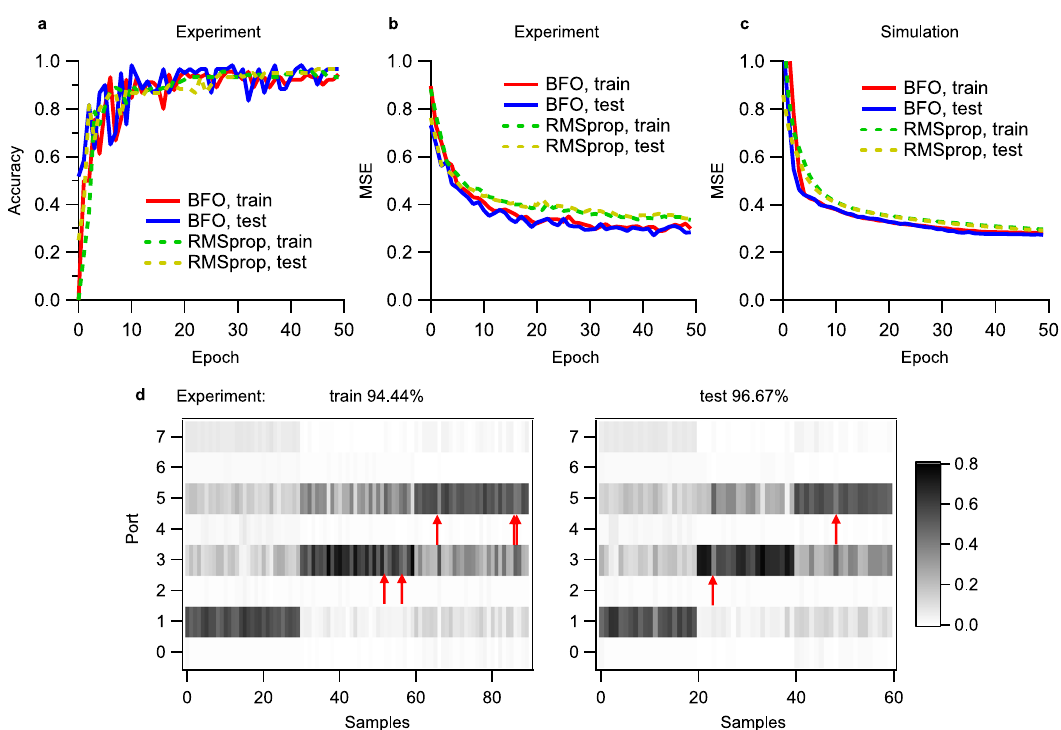
Fig. 5 Iris classi fi cation experiment. Comparisons between BFO and RMSprop training: a Experimental accuracy; b Experimental MSE; c Simulated MSE. BFO: bacterial foraging optimization. RMSprop: root mean square propagation optimizer. d Measured power map (normalized output power y = { p i / Σ p i }, p i denotes the optical power at the port i ) of the train set and test set after BFO training. Red arrows indicate the wrongly recognized samples. The train and test sets are explained in Methods. Source data are provided as a Source Data fi